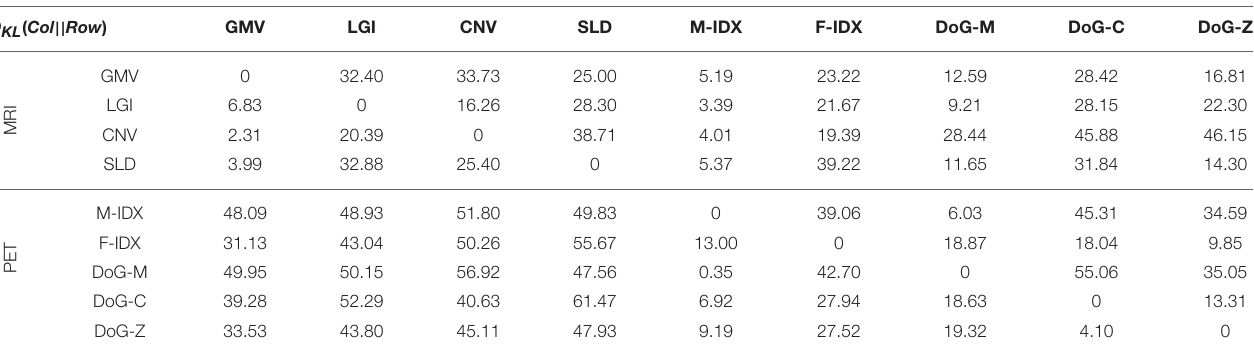
TABLE 1 | The cross-view Kullback-Leibler divergence between different views. D KL ( Col || Row